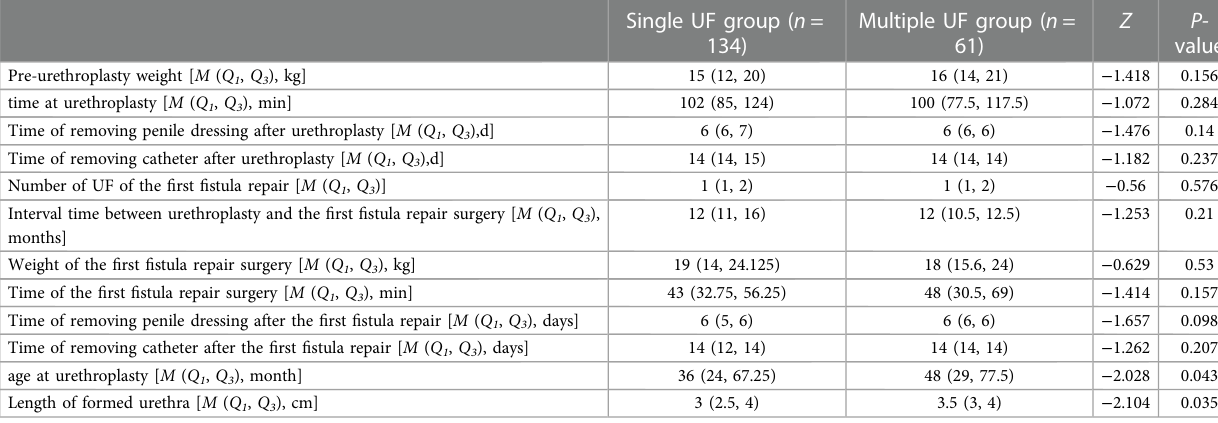
TABLE 1 Demographic characteristics of the single UF group and multiple UF